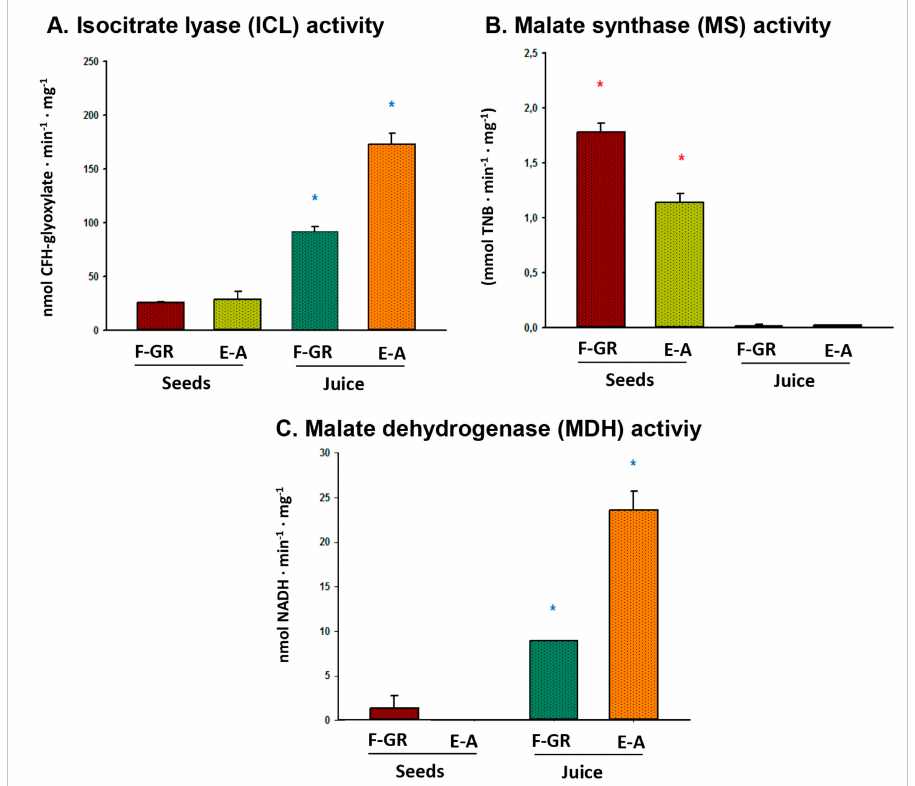
Figure 5. Activity of the peroxisomal glyoxylate cycle enzymes and malate dehydrogenase in seeds and juice from two Spanish pomegranate populations. Pomegranate fruits from El Fargue, Granada (F-GR) and Elche, Alicante (E-A) were analyzed. ( A) Isocitrate lyase (ICL); ( B ) malate synthase (MS); ( C ) malate dehydrogenase (MDH). Colored asterisks depict significant di ff erences ( p < 0.05) between either seed (red) or juice (blue) samples according to the Student’s t